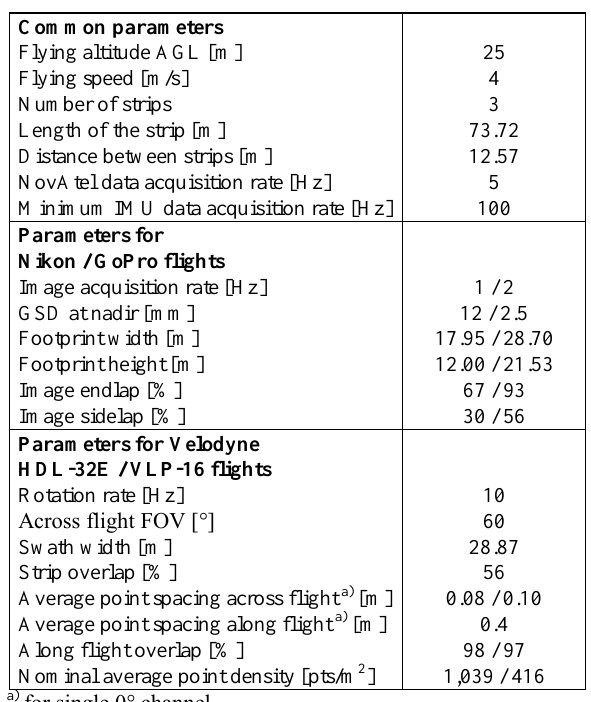
Table 4. Parameters of the flight and data acquisition